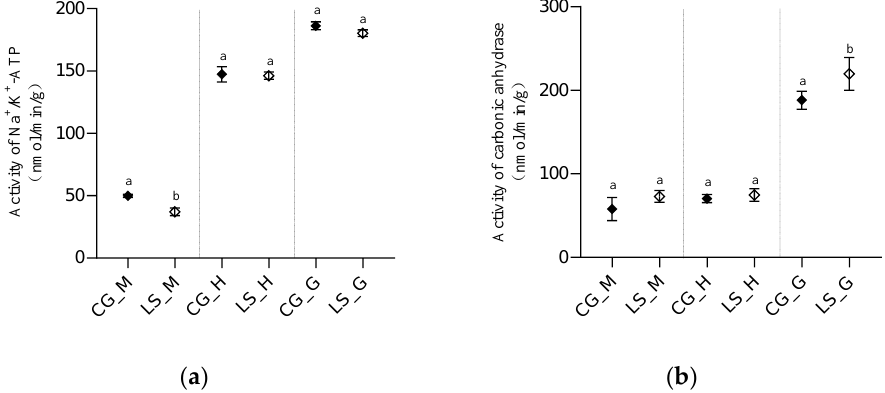
Figure 1. Enzyme activity in the different tissue of E. carinicauda in response to low salinity stress. ( a ) Carbonic anhydrase activity in the different tissue of E. carinicauda in response to low salinity stress; ( b ) Na + /K + -ATPase activity in the different tissue of E. carinicauda in response to low salinity stress. Different lowercase letters in the same tissue indicates that there is significant difference between groups ( p > 0.05). Abbreviations: M, muscle; H, hepatopancreas; G, gill.